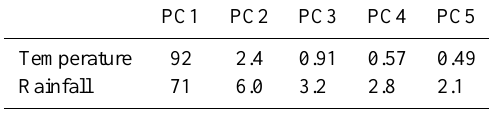
Table 3. Percentage of variance explained by the first five principal components of maximum daily temperature and total rainfall.